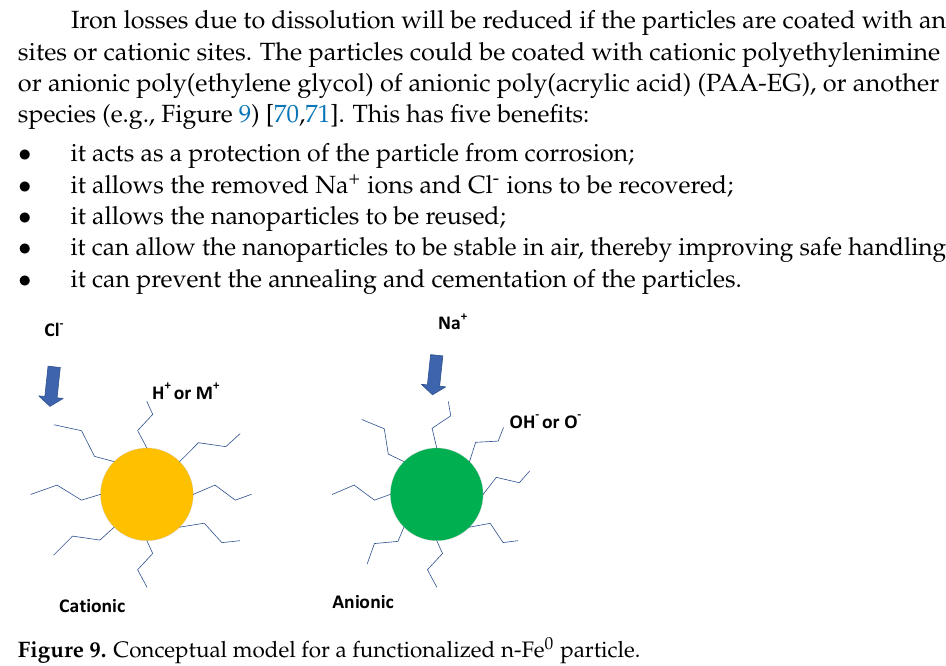
Figure 9. Conceptual model for a functionalized n-Fe 0 particle.